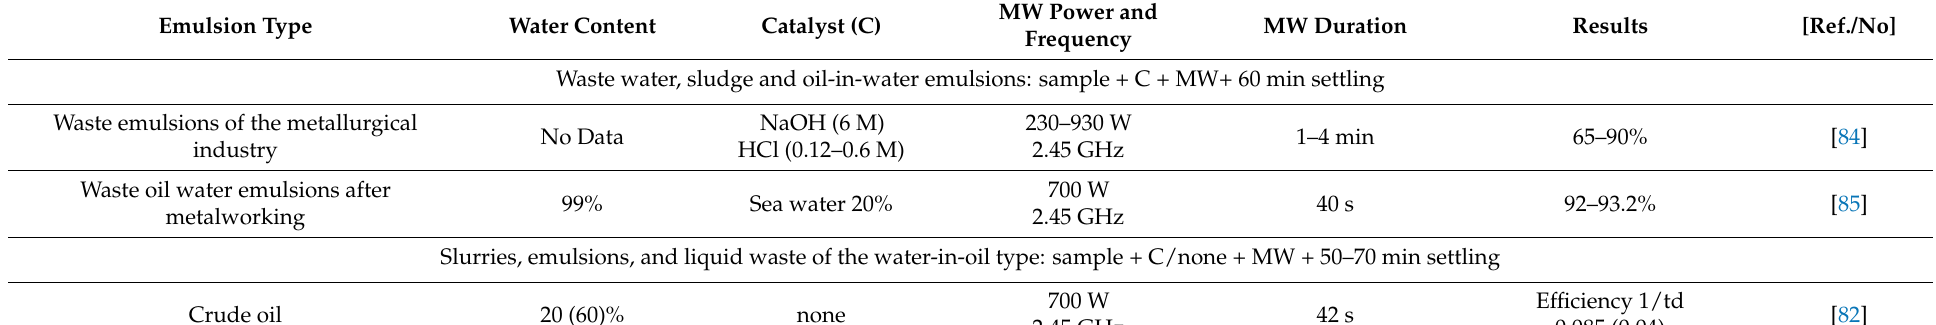
Table 7. Parameters and outcomes of several laboratory experiments on demulsification under the influence of